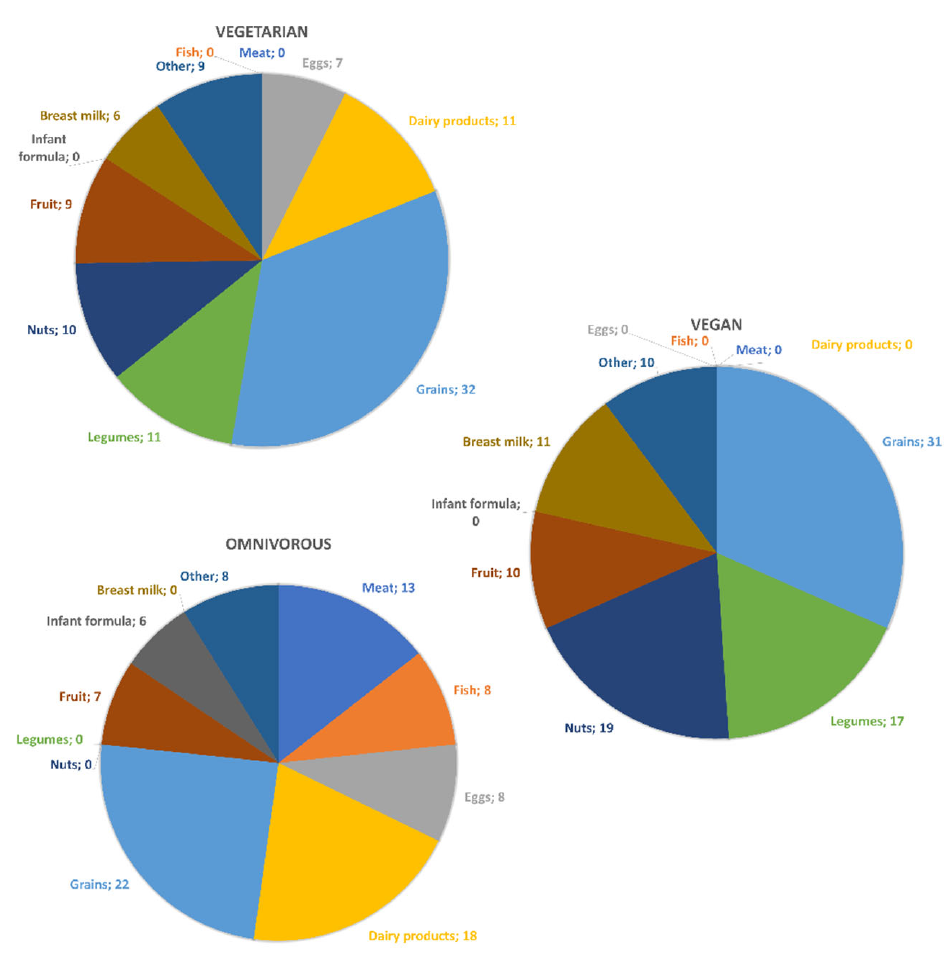
Figure 1. Percentage of selenium intake obtained from different food groups with a contribution of at least 5% to total selenium intake in vegetarian, vegan, and omnivorous 1- to 3-year-olds. 0 denotes 0% or <5%. Food groups which contributed 0–5% of selenium are: vegetarian (meat, fish, animal fats, and plant oils: 0% each; infant formula: 4%; potatoes: 2%; other vegetables: 4%; beverages: 3%), vegan (meat, fish, eggs, dairy, infant formula, and animal fats: 0% each; plant oils: 1%; potatoes: 2%; other vegetables: 4%; beverages: 3%), omnivorous (legumes: 3%; nuts: 3%; breast milk: 2%; animal fats: 0%; plant oils: 1%; potatoes: 2%; other vegetables: 2%; beverages: